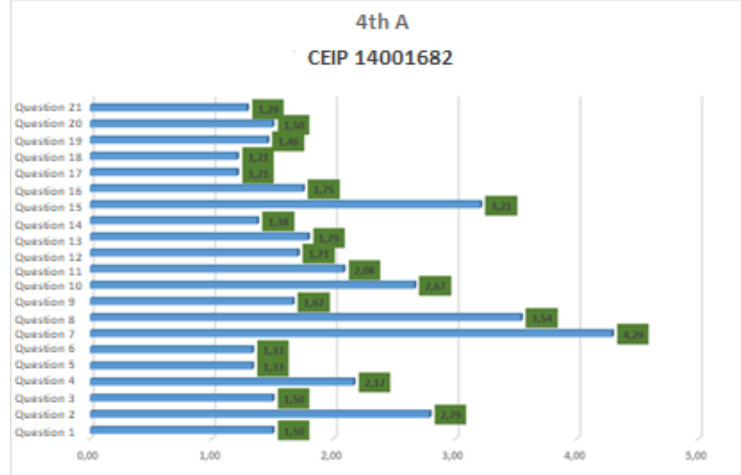
Figure 3 . Average questionnaires´ results 4 th A CEIP